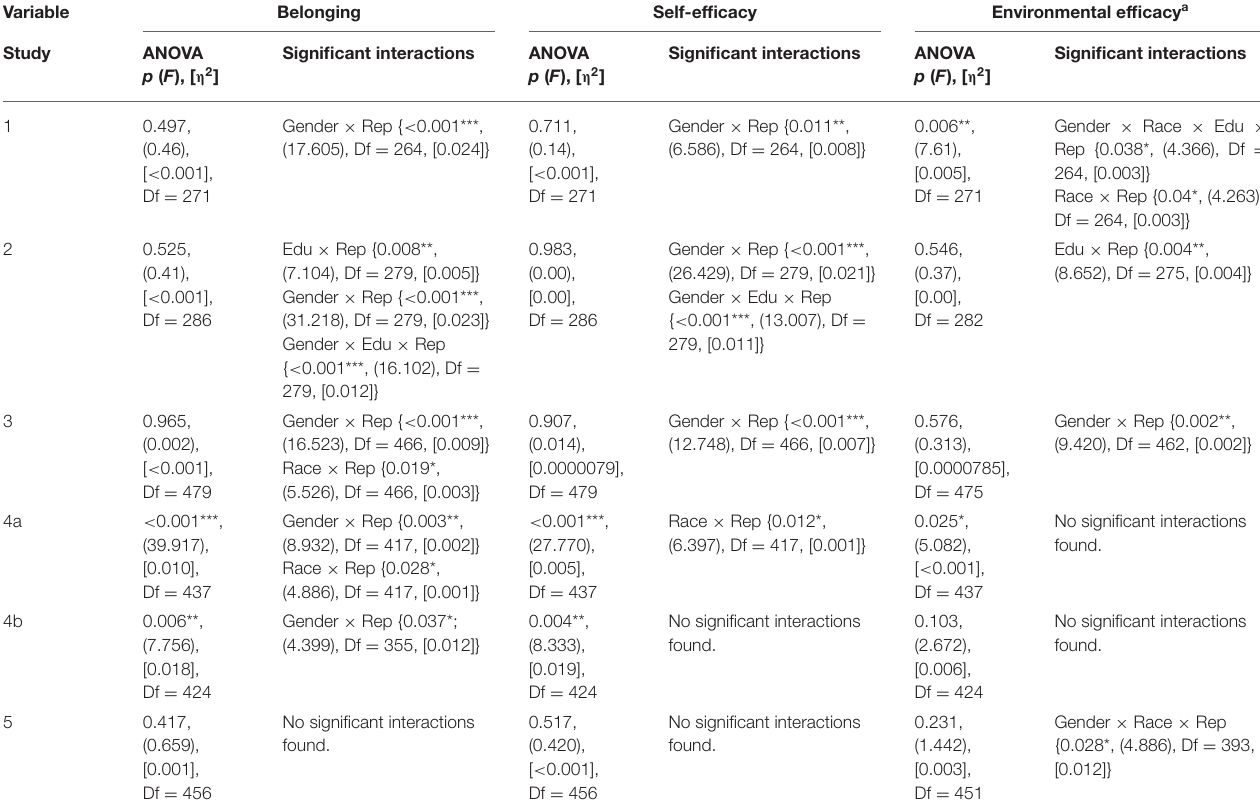
TABLE 8 | ANOVA and mixed ANOVA results for representation for all three dependent variables. Variable Belonging